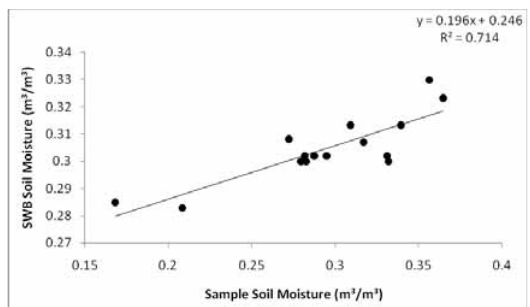
Figure 4: Relation between the SWB soil moisture vs the observed soil moisture